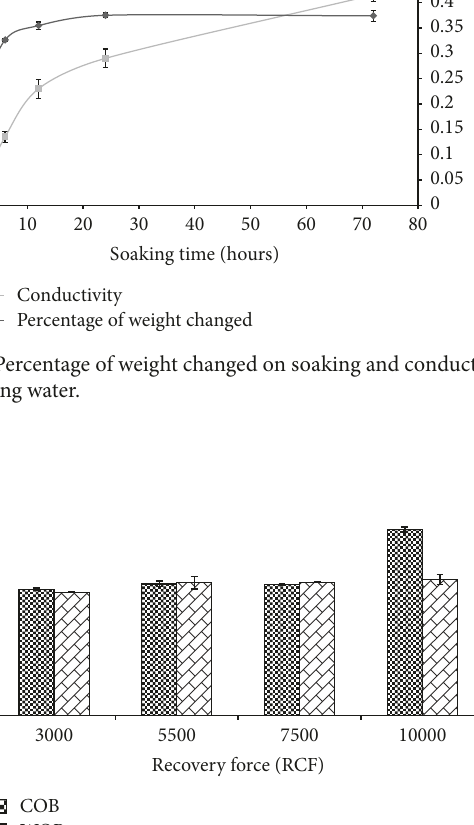
Figure 7: Particle size distributions of (a) crude oil body (COBs) and (b) washed oil body (WOBs) emulsions obtained using different recovery